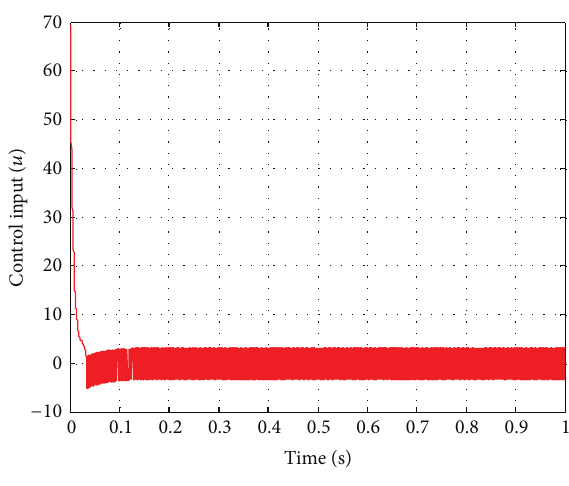
Figure 7: Control input ( 𝑢 ).